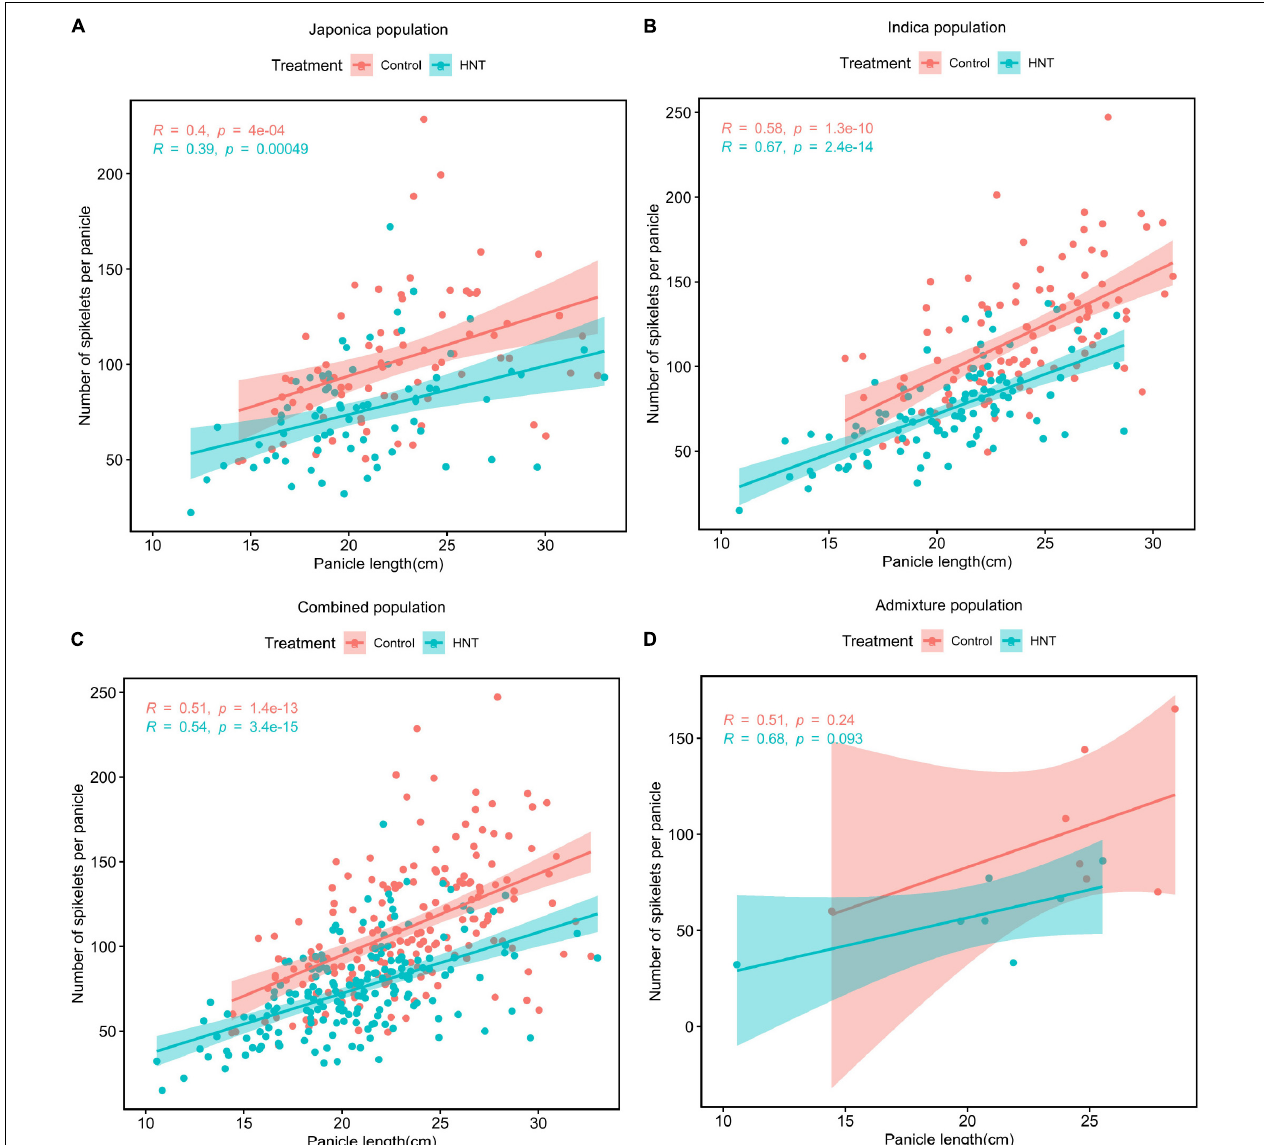
FIGURE 3 | Phenotypic correlations between PL (cm) and NSP under HNT stress and control treatments in the panel of 190 diverse rice accessions consisting of the (A) Japonica population, (B) Indica population, (C) Combined population, and (D) Admixture